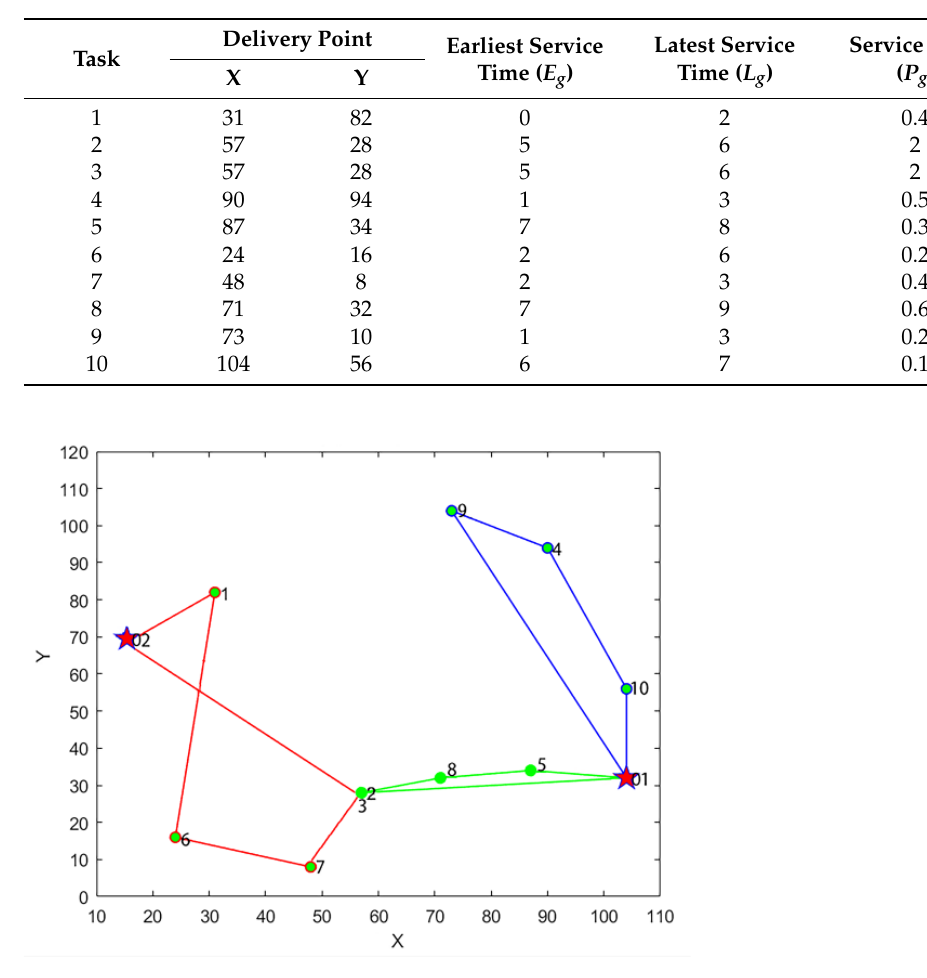
Figure 6. Final roadmap for 10 missions.